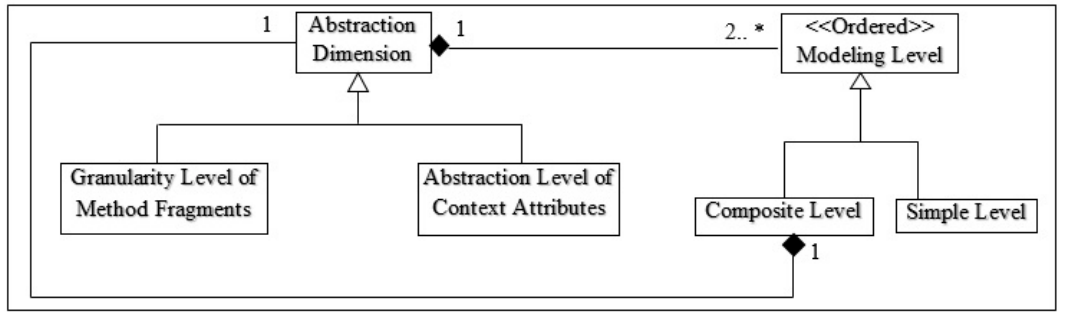
Figure 7. Proposed framework for defining the modeling levels.